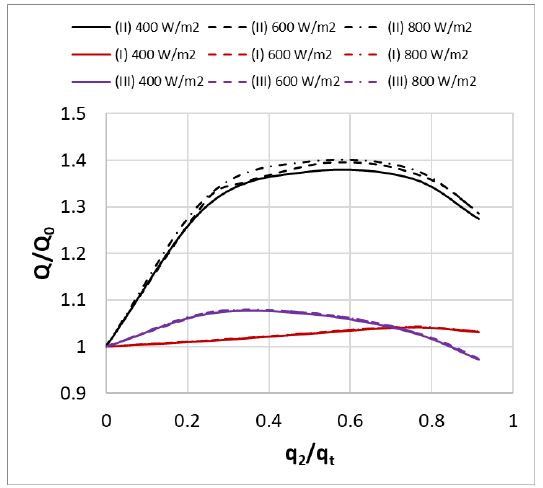
Figure 9. Changing the heat flux for three configurations with 𝐺 1 = 𝐺 2 = 0.1 m.